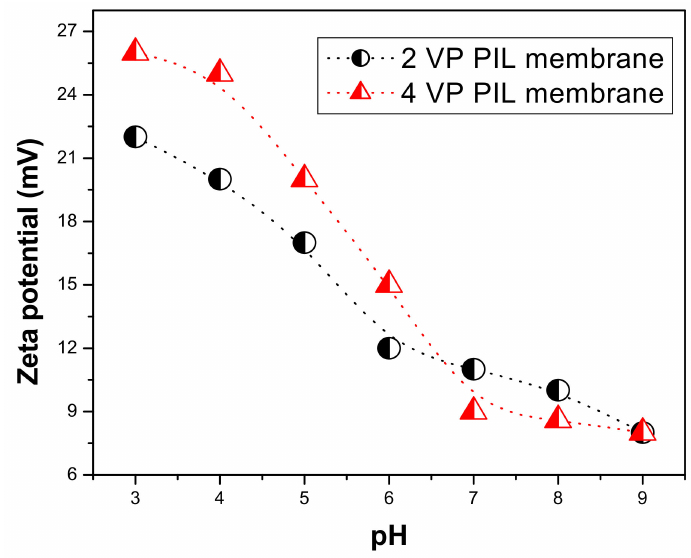
Figure 5. The zeta potential on PIL augmented membrane surfaces at various feed